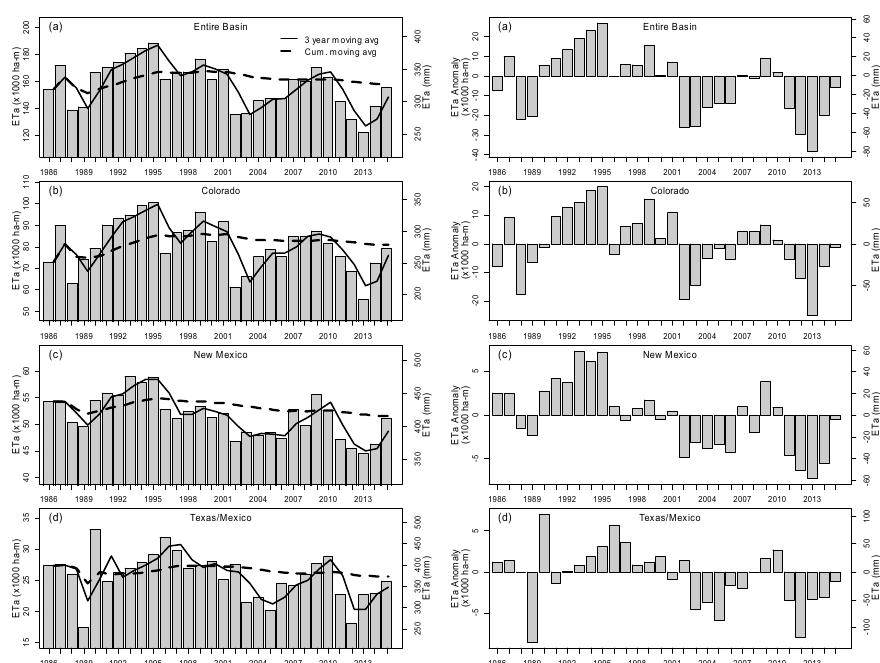
Figure 5. Seasonal water use and trends: ( a ) entire basin, ( b ) Colorado, ( c ) New Mexico, and ( d ) Texas / Mexico along with 3-year (solid-line) and cumulative (dash-line) moving averages and water use anomaly (right panel) by volume (ha-m) and by depth